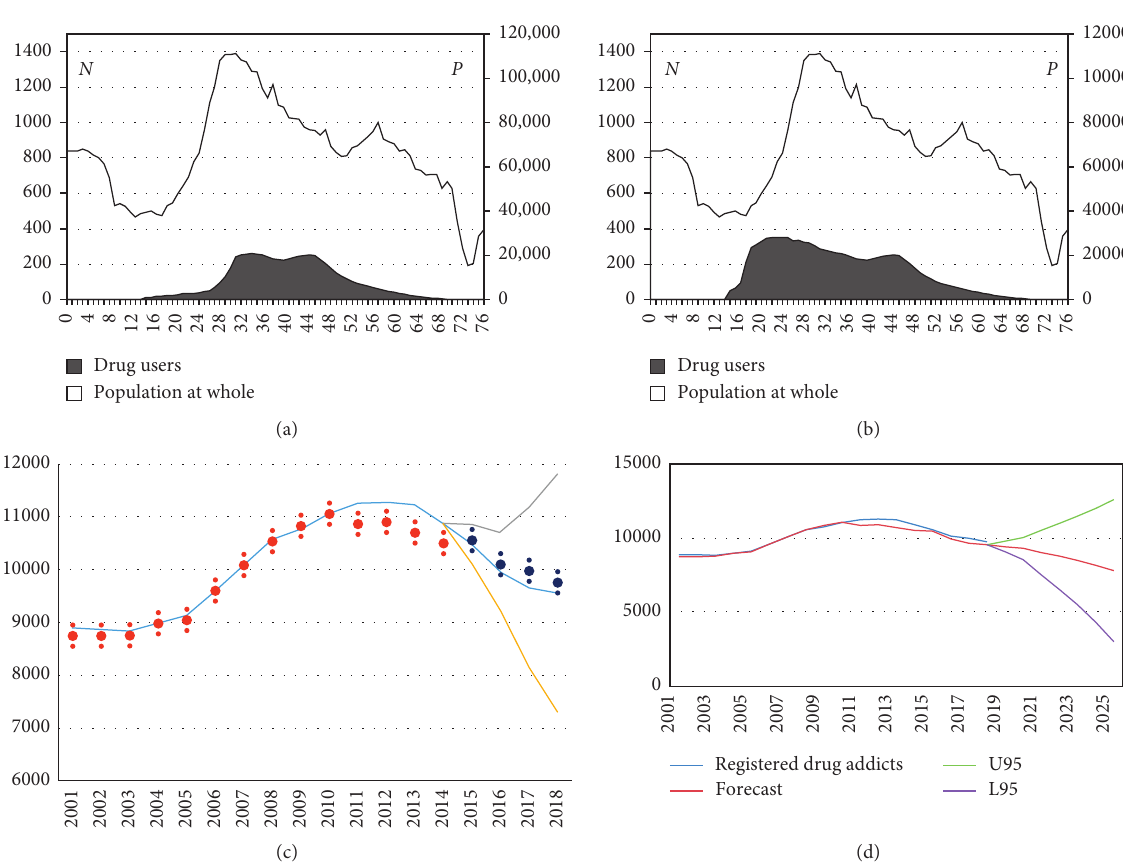
,..., I , ...,I and (b) pessimistic scenario I . (c) Demonstration of the model forecast on 10 12 10 12